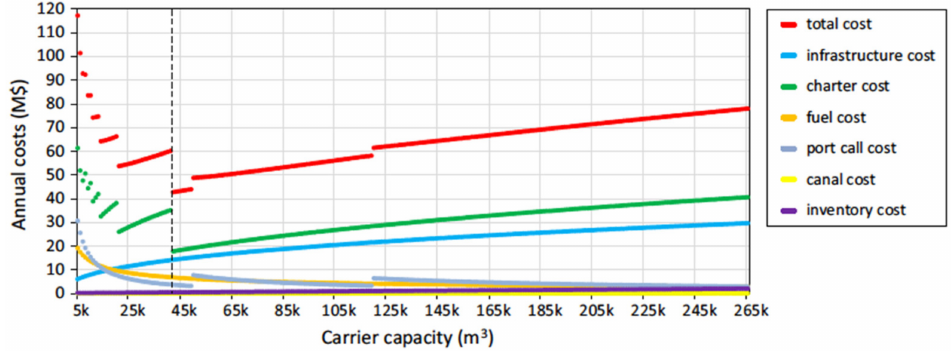
Figure 4. Cost Relationship and LNG Supply Chain Model